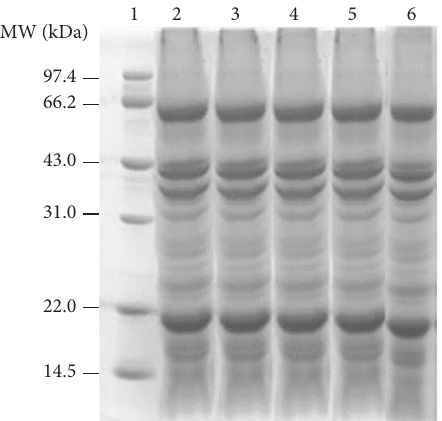
Figure 3: SDS-PAGE of peanut protein extracted by various en- zymes: (1) standard protein; (2) Viscozyme ® L; (3) cellulase; (4) hemicellulase; (5) pectinase; (6)